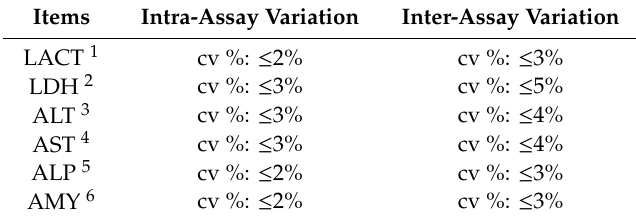
Table 2. The intra-assay variation and inter-assay variation of kits for twelve goats’ metabolites. Items